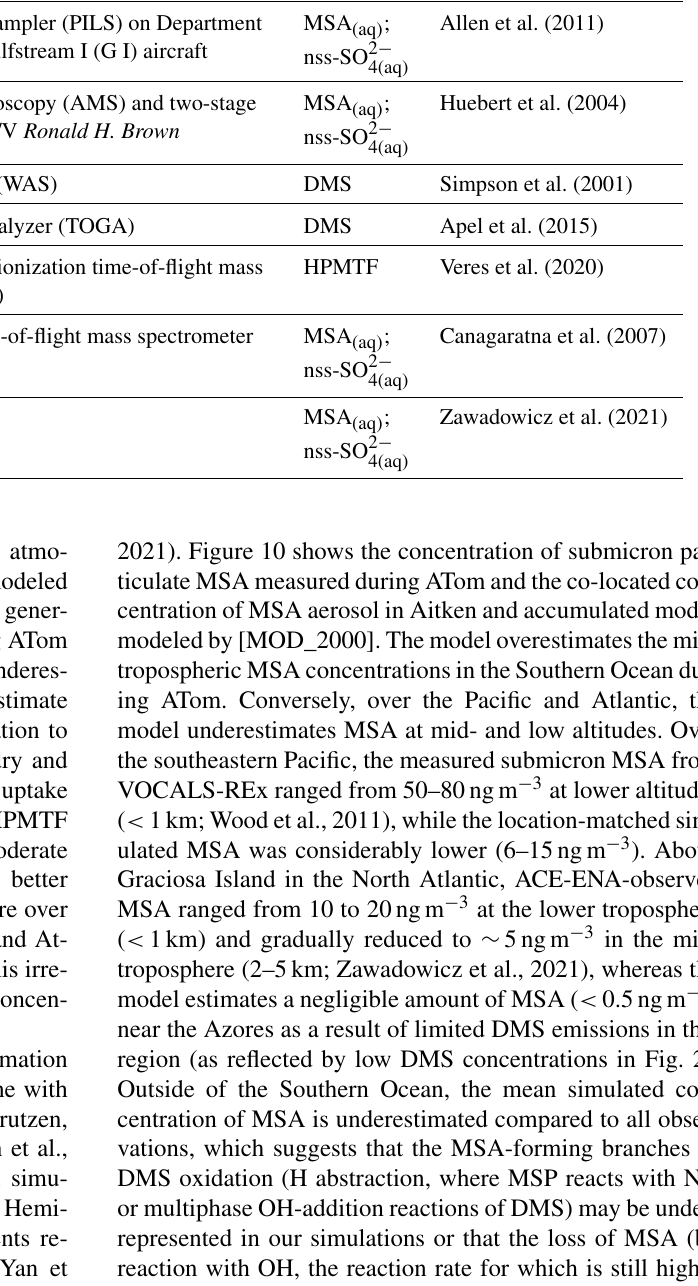
Table 9. Key observational datasets used in this study. Mission Aliases Instruments Species Reference measured VOCALS- OBS_BROWN Quadrupole mass spectrometry on research vessel Quadrupole mass spectrometry on